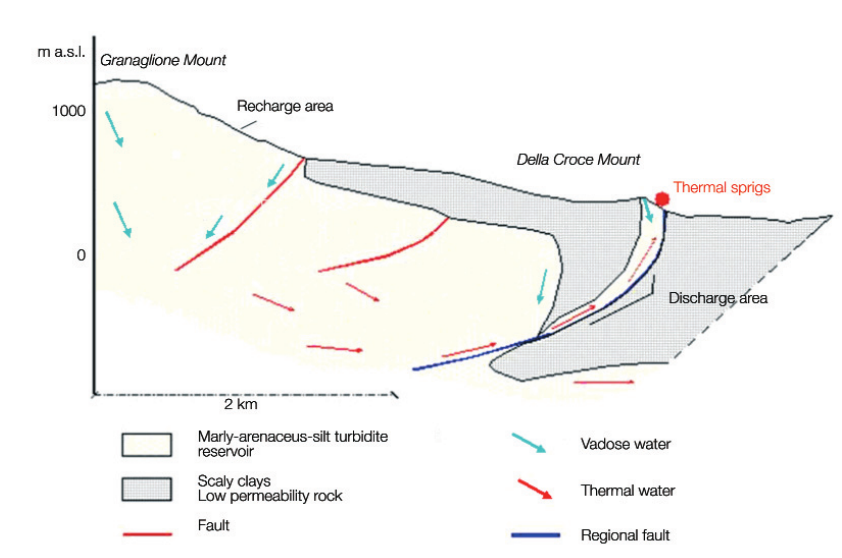
Fig. 3. Schematic section showing the recharge area/thermal springs relative positions and the main structures governing the groundwater circulation through the different